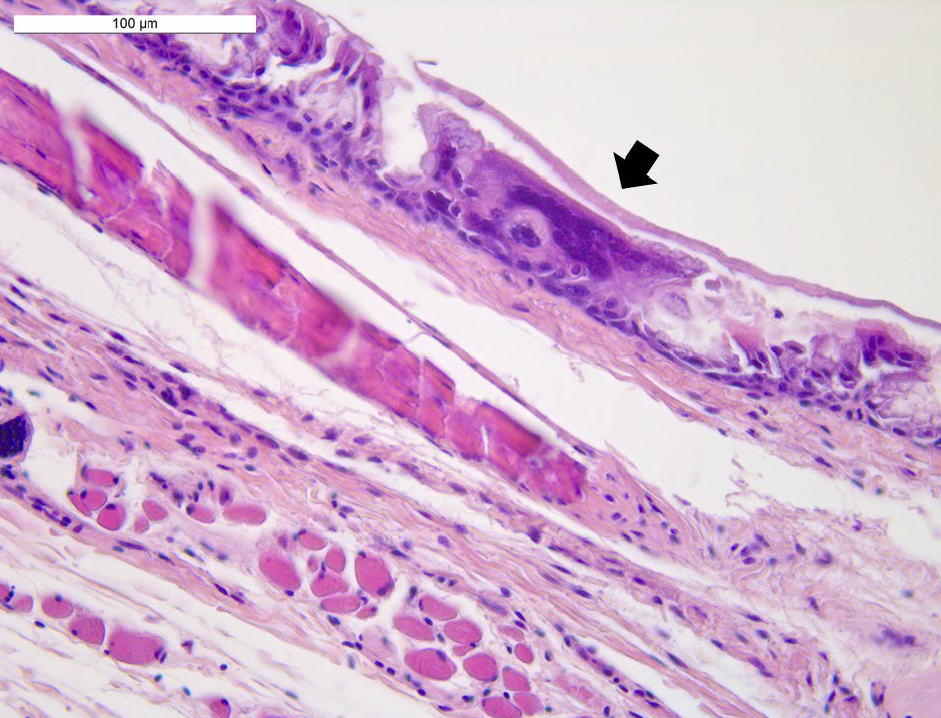
Figure 3. Trachea: necrosis and desquamation of epithelial cells with the presence of syncytial multinucleated cells and superficial muco-fibrinous material (arrow). Hematoxylin and eosin (40× objective). Bar = 100 µm.